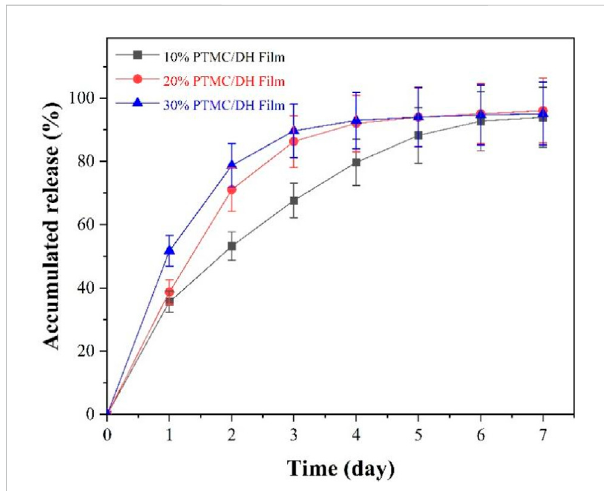
FIGURE 4 In vitro cumulative release of doxycycline hydrochloride.